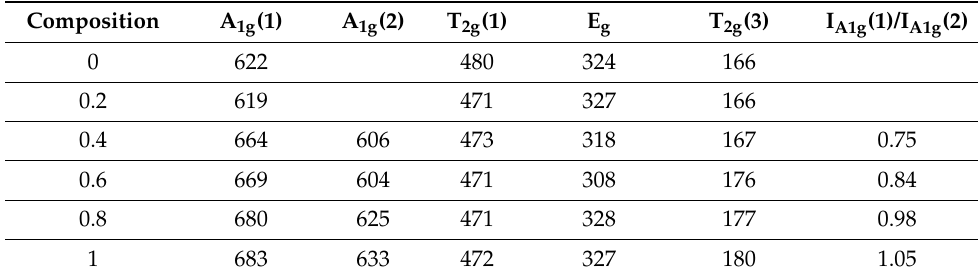
Table 2. The peak positions and intensity ratios of Co x Mn 1-x Fe 2 O 4 ( x = 0.0, 0.2, 0.4, 0.6, 0.8, and 1.0)